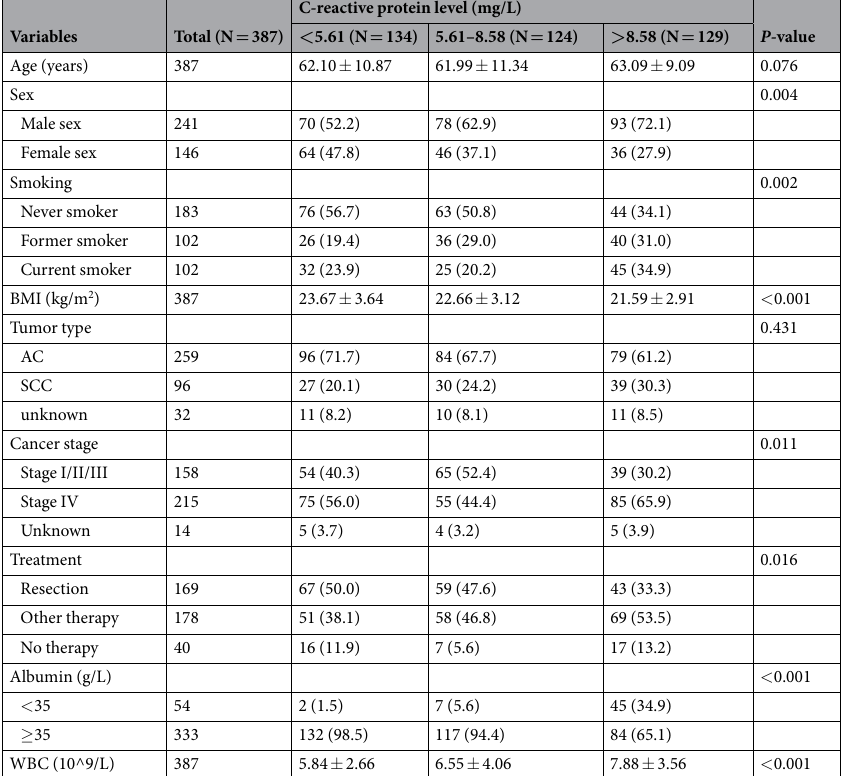
Table 1. The relationship between C-reactive protein and clinicopathological characteristics in NSCLC patients. BMI, body mass index; AC, adenocarcinoma; SCC, squamous cell carcinoma; WBC, white blood cell